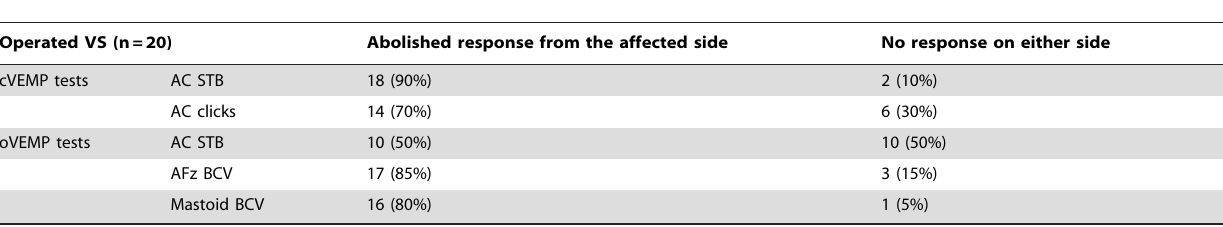
Table 6. Number (%) of operated VS patients (n=20) with abnormal responses or no responses on either side to VEMP tests.